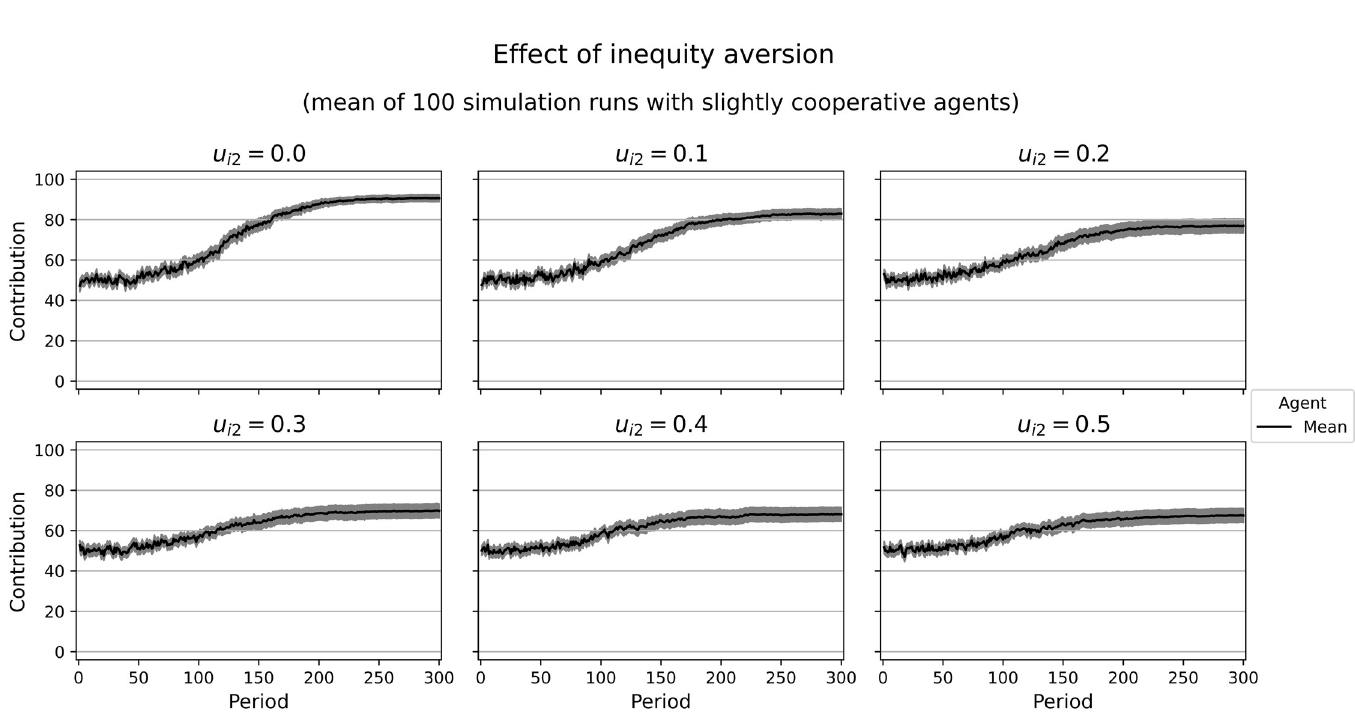
Fig 7. Contributions of rather cooperative agents with different weights of inequity aversion. Selfishness: 0.66, competitiveness: 0, social welfare: 0, altruism: 0.34. Marginal utility of the own contribution: 0.03. In gray: confidence interval (95%) around the mean.